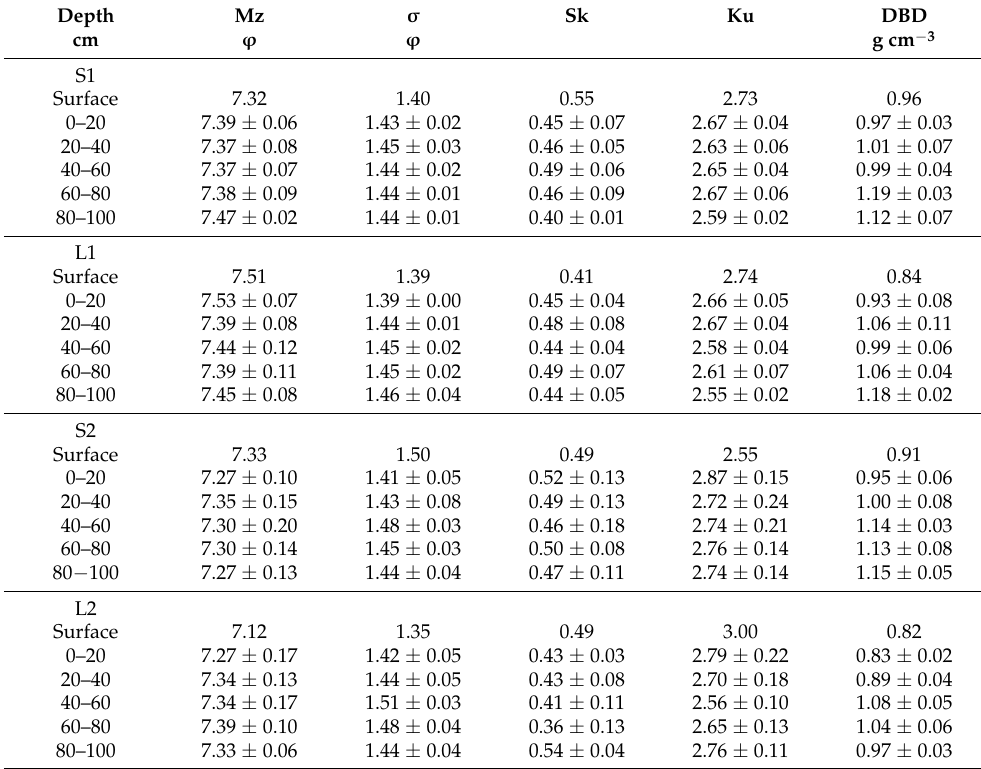
Table A1. Results of Mz, σ , Sk, Ku and